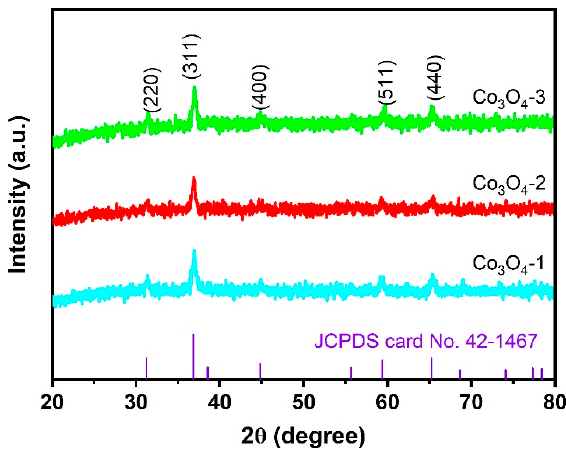
Figure 1. X-ray powder diffraction (XRD) patterns of Co 3 O 4 -1, Co 3 O 4 -2 and Co 3 O 4 -3.